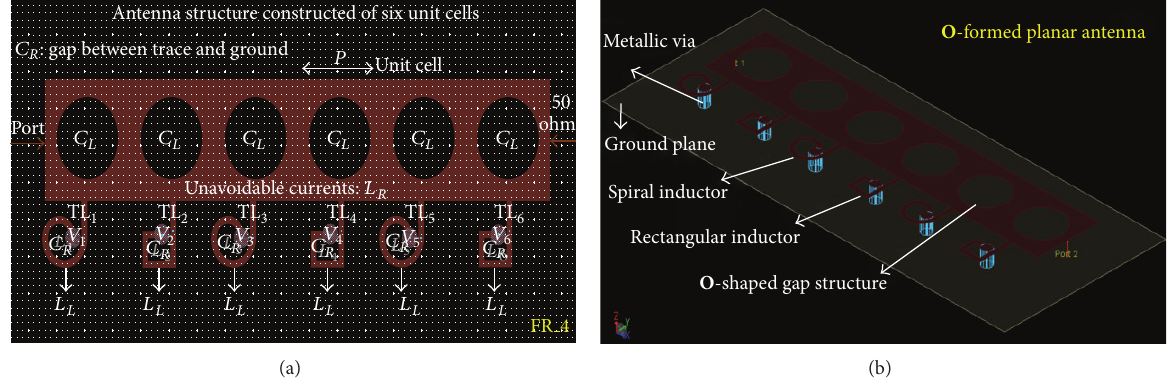
Figure 8: Arrangement of elements of the latter antenna composed of six O -formed unit cells: (a) top view, (b) isometric